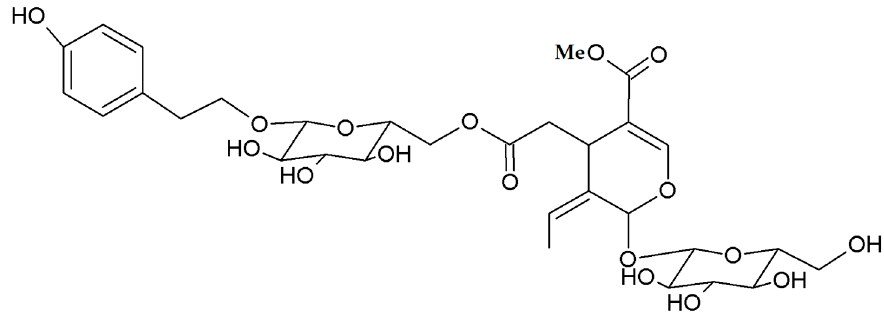
Figure 3. Chemical structure of nüzhenide, the major phenolic constituent of the polar olive seed extracts.